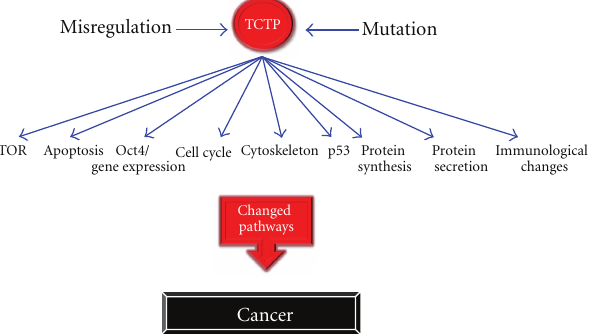
Figure 2: Pathways in which TCTP misregulation or mutations could cause